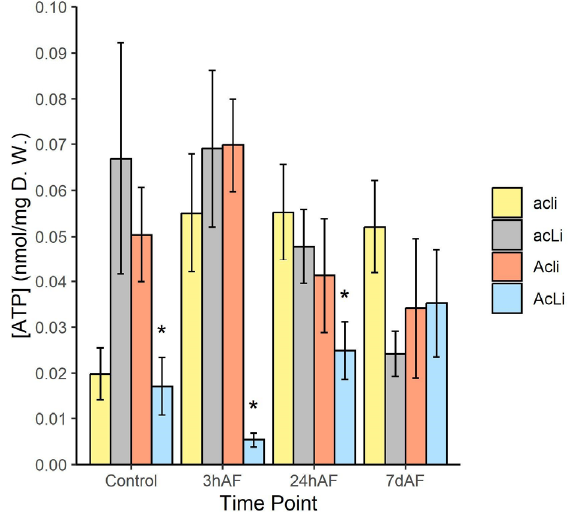
Figure 4. ATP concentrations in nmol/mg dry weight in leaves of four T. repens cyanotypes at four time points: Control (no freezing), 3 h after freezing (3hAF), 24 h after freezing (24hAF), and 7d after freezing (7dAF). Asterisks (*) represent significant differences ( p < 0.05) within time points between cyanogenic (AcLi) and acyanogenic (average of Acli, acLi, and acli) plants based on custom contrasts (see Methods).